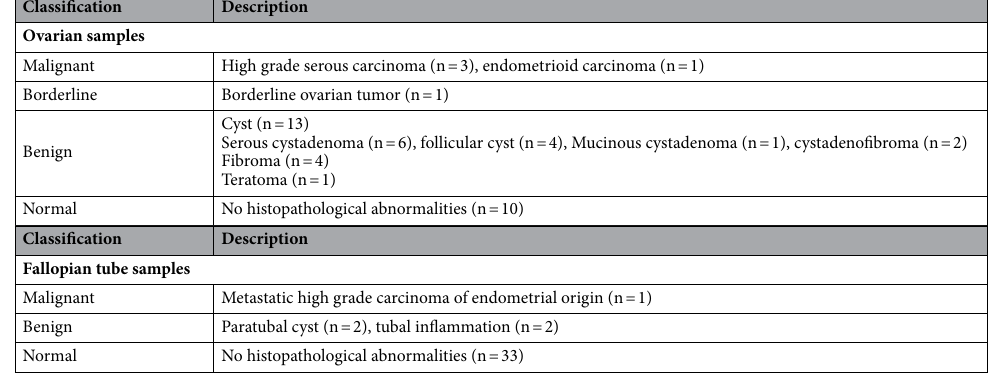
Table 1. Summary of all different ovarian and tubal pathologies observed in this study, from a cohort of 38 patients with 32 ovarian ROIs and 38 tubal ROIs.